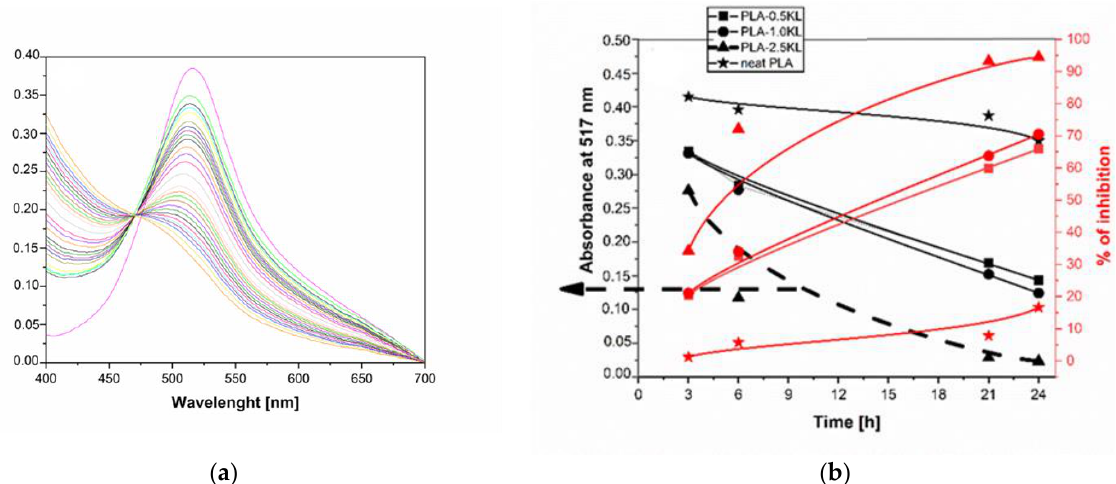
Figure 9. ( a ) The absorbance of PLA-2.5 TANN composites as a function of Wavelength (blue) and ( b ) reaction kinetics and % of inhibition of the PLA based TANN composites film evaluated with DPPH radical scavenging in the methanol solution indicated during 24 h (red).